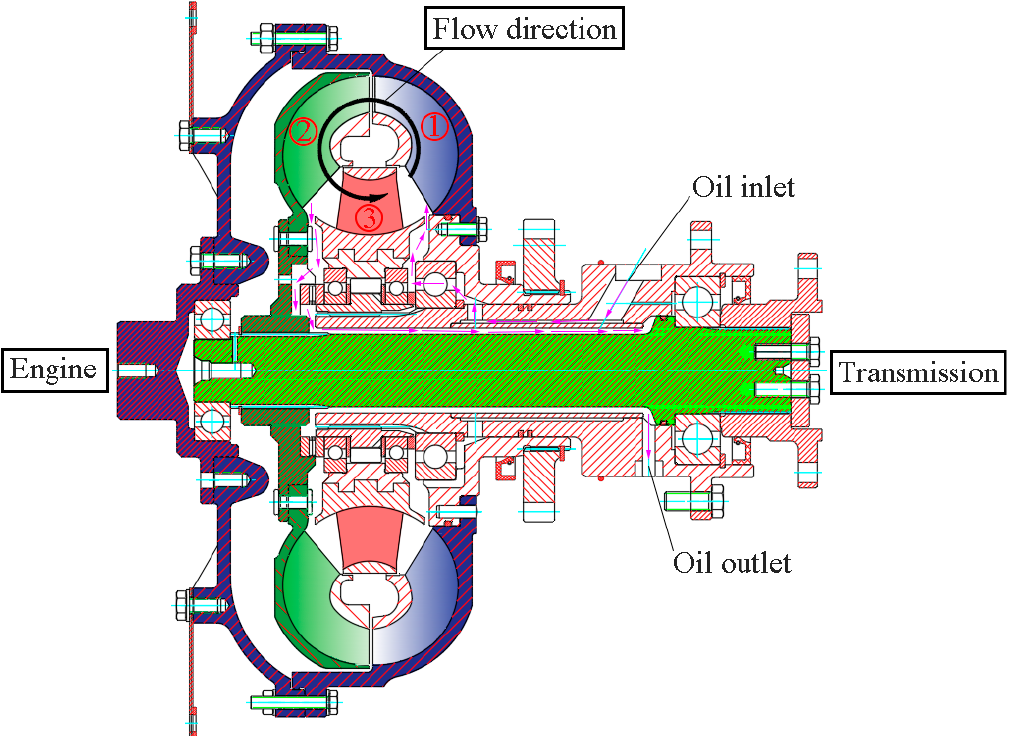
Figure 3. Hydrodynamic torque converter cross-section view (1-pump, 2-turbine, and 3-stator). Appl. Sci. 2021 , 11 , x FOR PEER REVIEW